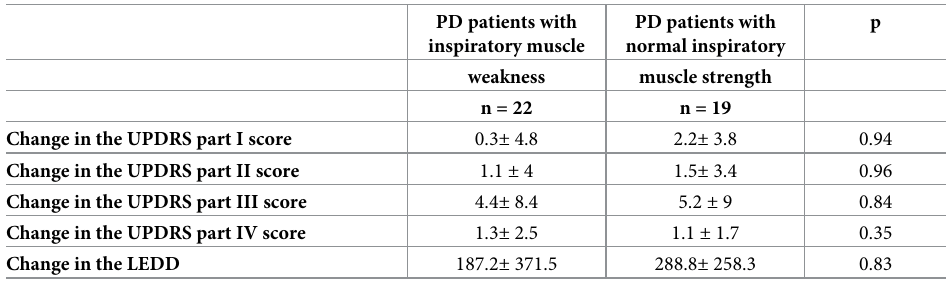
Table 5. Comparison (in an analysis of covariance) of clinical changes between V1 and V2 in PD patients with and without inspiratory muscle